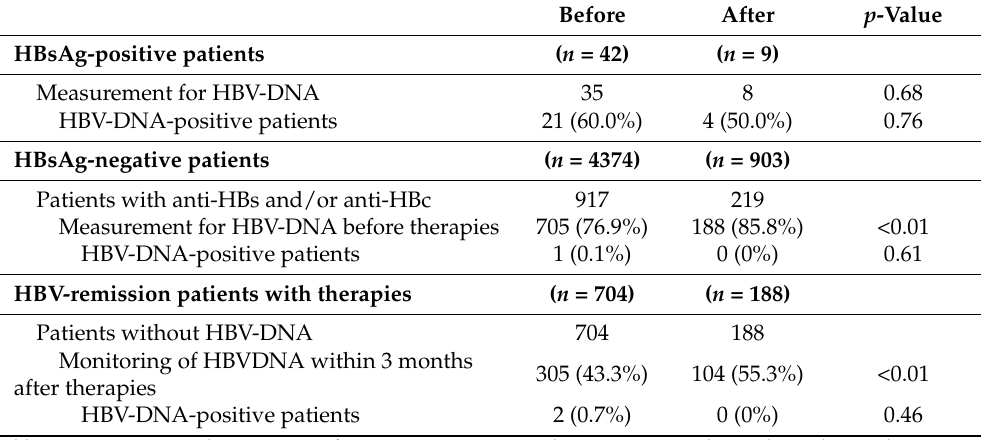
Table 2. Measurement rates of HBV-DNA in patients before and after the introduction of the alert system.